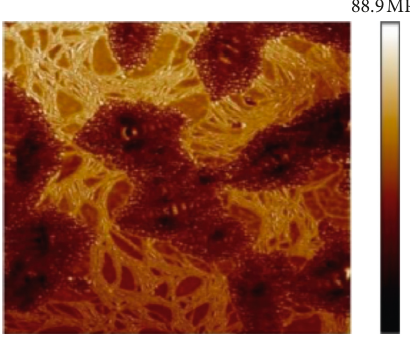
Figure 22: Modulus profile of an asphalt sample of 20 × 20 micrometer.